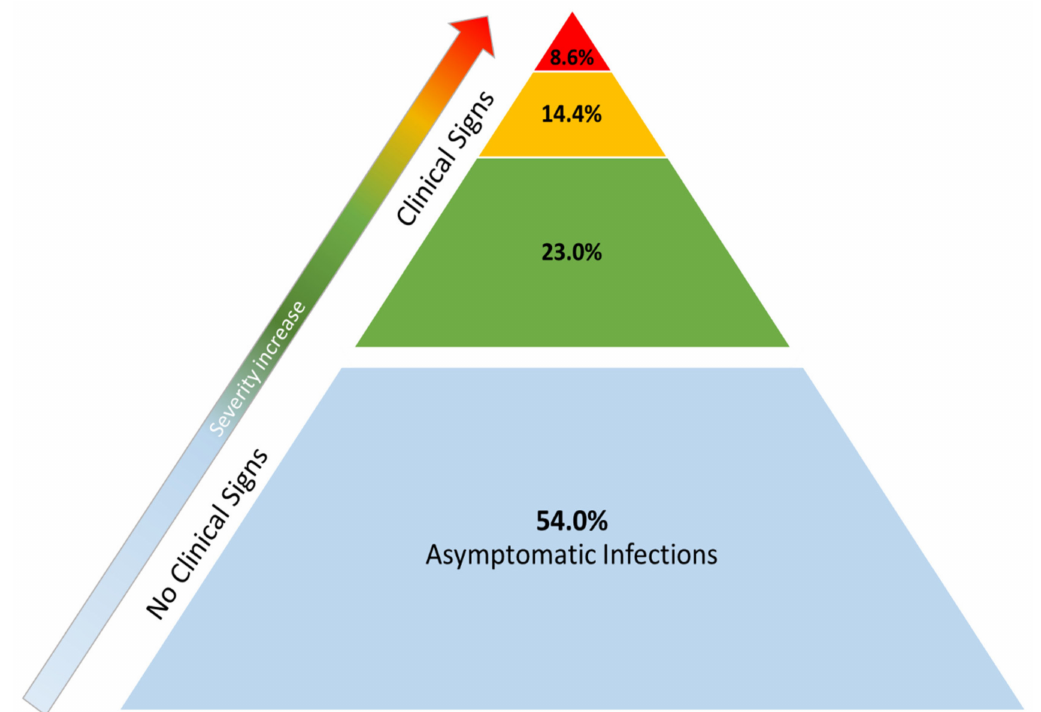
Figure 4. Distribution of outcomes in cats with SARS-CoV-2 infection in published case reports . The base of the pyramid denotes asymptomatic infections (blue area). In clinically ill animals, the vast majority of symptomatic cases presented mild clinical signs (green area). Approximately one third of the symptomatic animals showed medical complications of major clinical relevance (yellow area). A smaller percentage of animals (red area) eventually died after being diagnosed with SARS-CoV-2 infection: four of those had underlying health problems—which is why SARS-CoV-2 was considered incidental rather than a cause of death—and the remaining two were euthanized due to worsening of their clinical